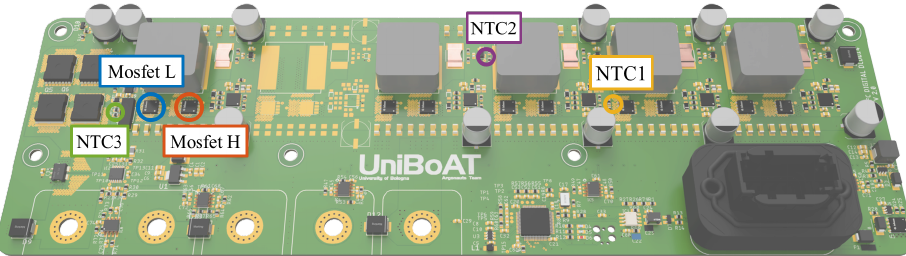
Figure 19. Data acquired during the sea trial with the reference input current target of 40 A ( top ): input power ( middle ) and output power ( bottom ).